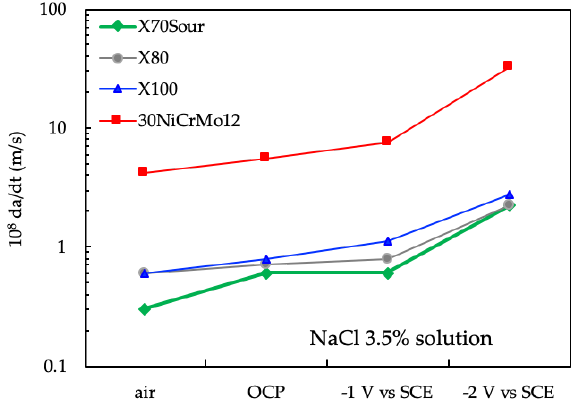
Figure 9. crack growth rate as a function of time for the API 5L X00 steel in air (blue curve) and in NaCl 3.5% solution at −2 V vs. SCE (red curve).